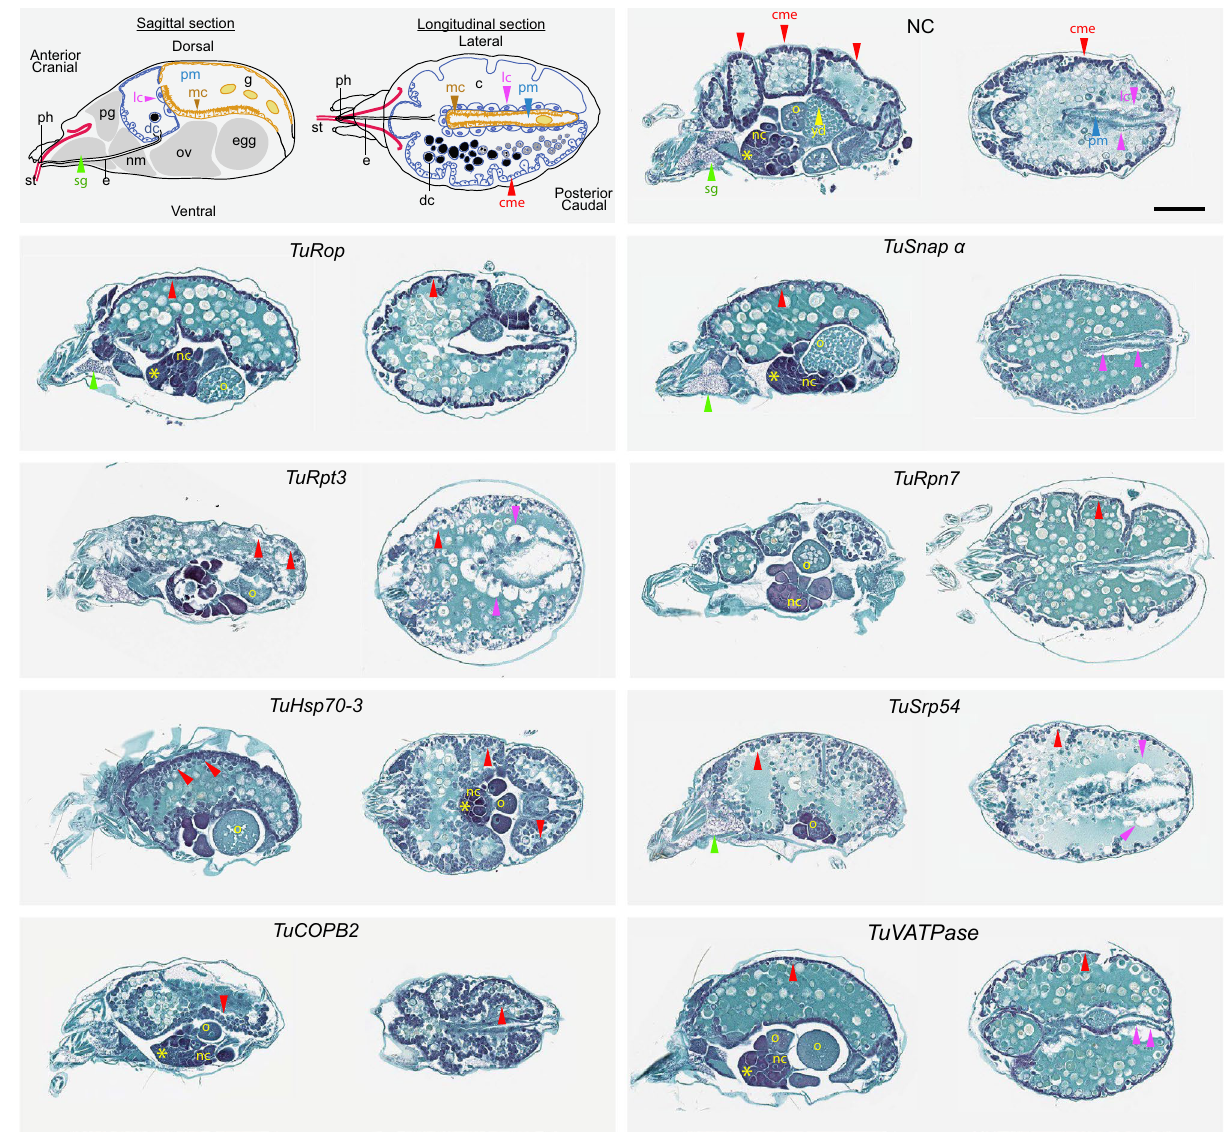
Figure 5. Histological analysis of mite RNAi phenotypes. Schematics depicting the internal anatomy of T. urticae female (top left, adapted from Bensoussan et al. 42 ). On the left side of the panel—sagittal, and on the right—longitudinal sections through mite body. Stylet (st); pharynx (ph); esophagus (e); caeca (c); digestive cell (dc); microvilli cells in posterior midgut (mc in pm); prosomal gland (pg); nervous mass (nm); guanine pellet (g). Tissues of interest are labeled with arrowheads: red, caecal midgut epitheli cells (cme); magenta, large cells (lc); blue, posterior midgut (pm); green, silk gland (sg); yellow, ovaries: asterisk, previtellogenic cells; nc nurse cells; o oocyte; yd yolk droplets within the oocyte. Higher magnifications of tissues with perturbed cellular morphologies are shown in Fig. 6. Scale bar: 100